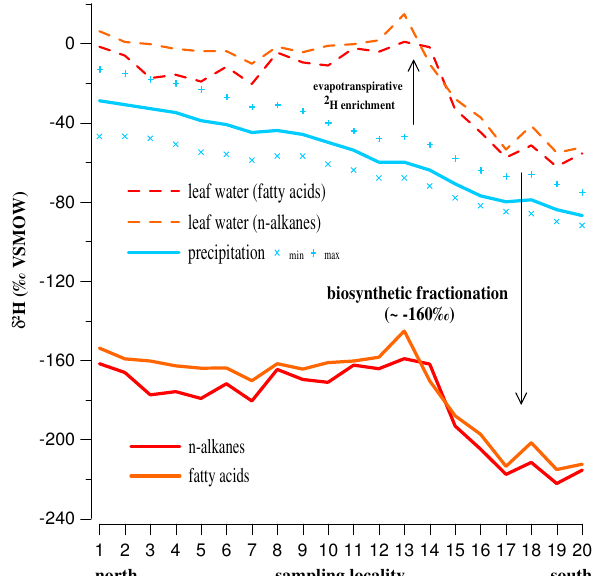
Figure 3. Comparison of measured δ 2 H n -alkanes (weighted mean of n − C 29 and n − C 31 ) and δ 2 H fattyacids (weighted mean of n − C 22 , n − C 24 , n − C 26 , n − C 28 and n − C 30 ) patterns with δ 2 H prec (Bowen, 2012) along the north–south climate transect ( x min and + max representing annual minimum and maximum value at the sampling sites). Additionally, assuming a biosynthetic fractionation of − 160‰ for the n -alkane and fatty acid biosynthesis in plants the biomarker-based reconstructed isotopic composition of leaf water is shown.